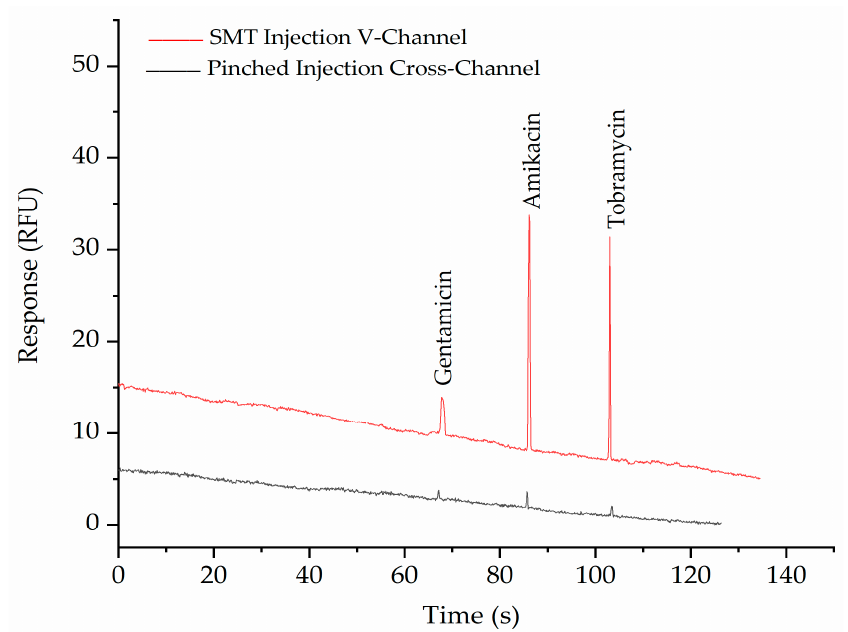
Figure 4. Electropherograms show the comparison of SMT (red trace) with pinched injection (black trace) of 5 ppm Gentamicin, 20 ppm Amikacin, and 10 ppm Tobramycin after labelling with fluorescamine. The BGE in the V- sample waste channel was 10 mM phosphate buffer, pH 11.5, while in the separation channel, it was 100 mM phosphate buffer, pH 11.5, with 0.5% HPMC. Applied voltages for SMT were − 100, − 700, − 500, and +500 V for 60 s and for separation were − 300, +220, +2000, and − 400 V at reservoirs B, S, BW, and SW, respectively. For pinched injection (cross-channel), all channels were filled with 100 mM phosphate buffer, pH 11.5, with 0.5% HPMC. Applied voltages for injection were − 100, − 400, − 300, and +400 V at B, S, BW, and SW reservoirs, respectively, and separation voltages were − 200, +400, +1500, and +400 V at B, S, BW, and SW reservoirs, respectively.